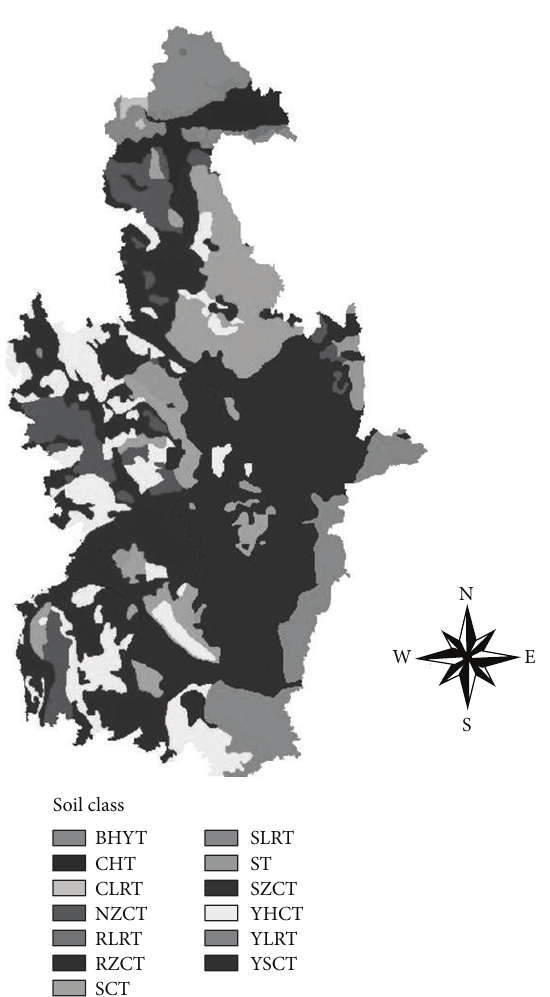
Figure 7: Soils in Tianjin.